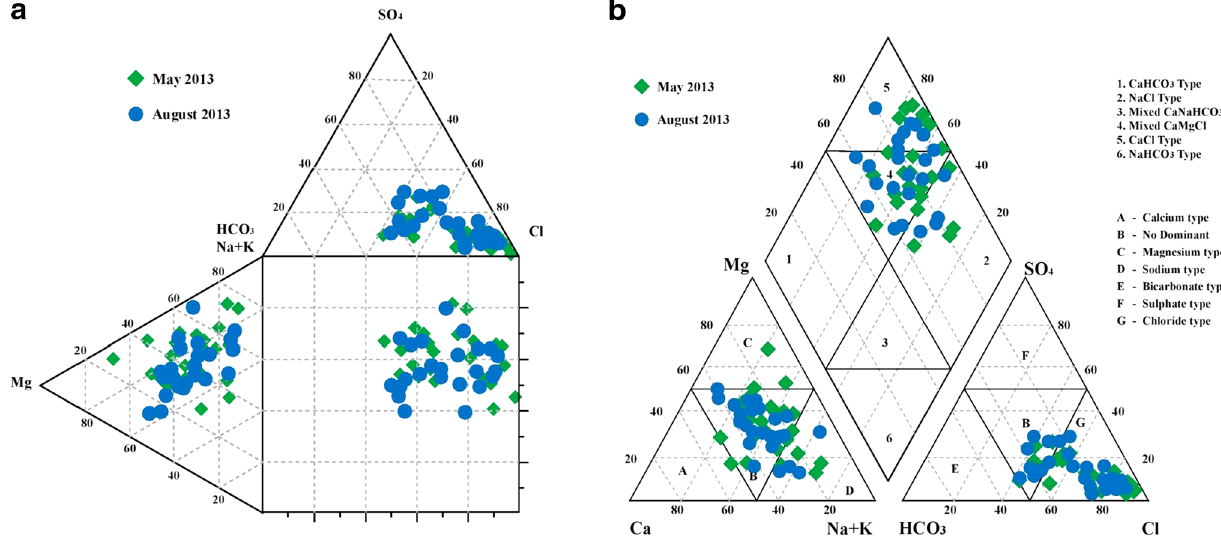
Fig. 6 a , b Classification of groundwater based on the Durov and Piper Trilinear